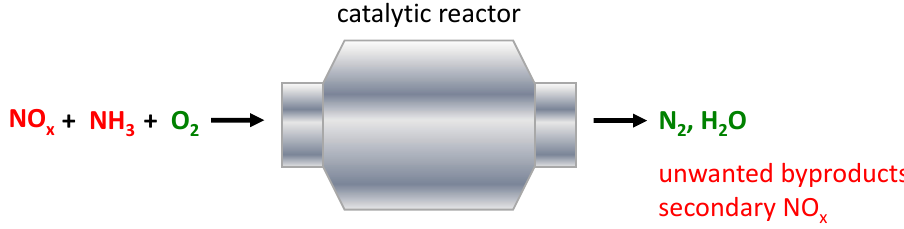
Figure 5. Schematic illustration of the catalytic NH 3 SCR deNO x process.